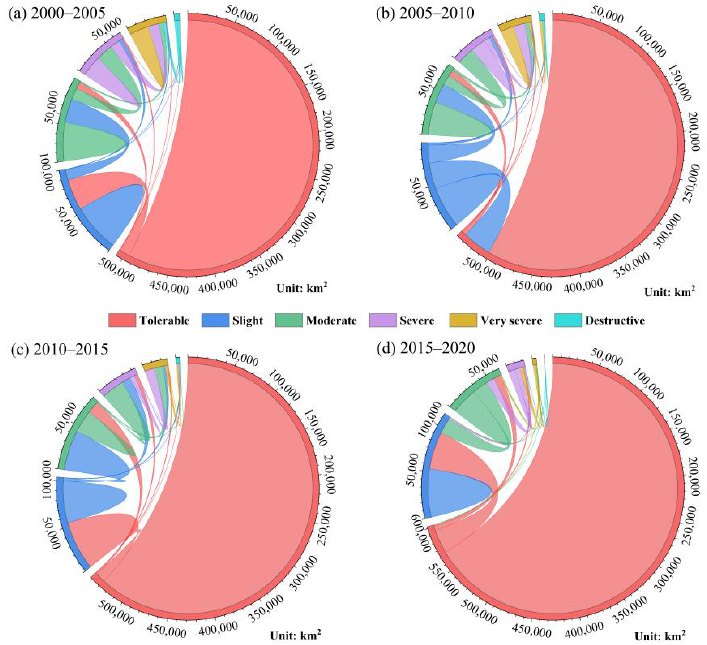
Figure 3. Shift in soil erosion intensity: ( a ) 2000 – 2005; ( b ) 2005 – 2010; ( c ) 2010 – 2015; ( d ) 2015 – 2020. Soil erosion in the YRB occurs mainly in the loess area and gradually disperses as the scale decreases, with obvious regional differences in space (Figure 4). The high erosion areas at the provincial scale are mainly concentrated in Gansu, Shaanxi, and Shanxi prov- inces. In 2020, almost all counties and cities with serious soil erosion were concentrated in these three provinces. At the city scale, high-erosion areas mainly include Baiyin, Zhong- wei, and Qingyang in Gansu Pr ovince, Yan’an and Yulin in Shaanxi Province, and Linfen and Luliang in Shanxi Province. At the county scale, high erosion areas mainly include